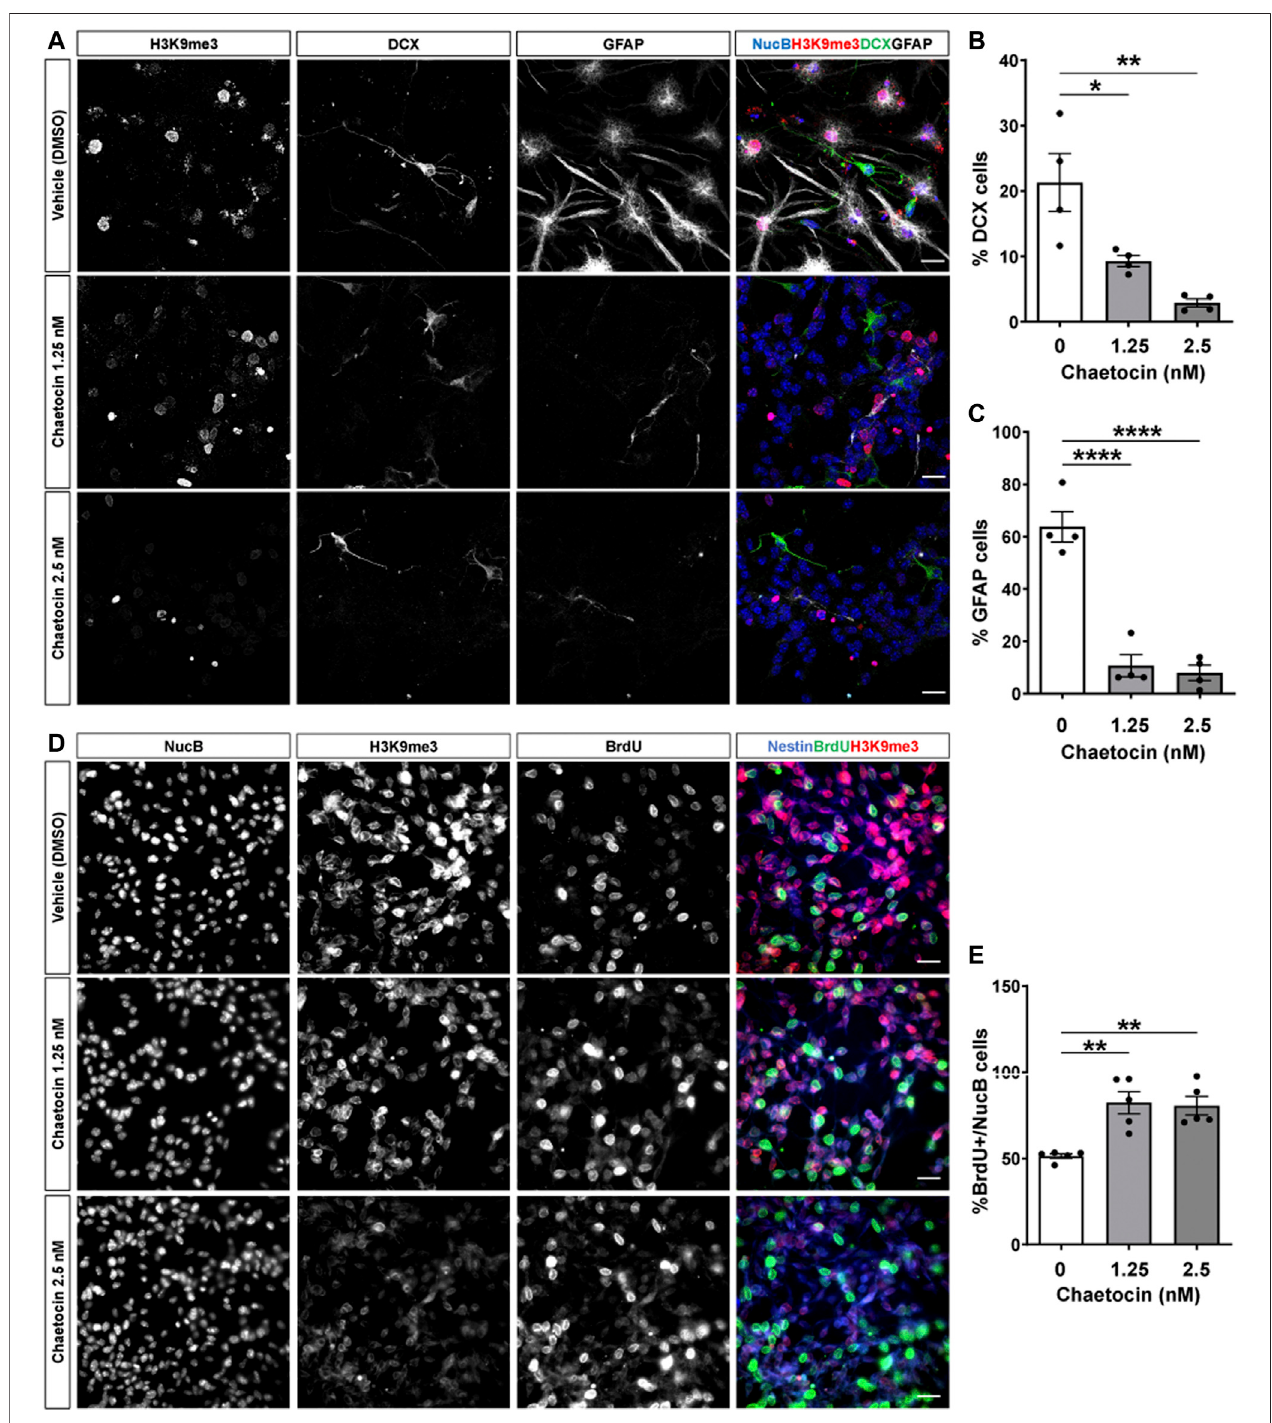
FIGURE 6 | Chaetocin induces proliferation and reduces differentiation of cultured adult hippocampal progenitors. (A) Immunostaining of H3K9me3 (red), DCX (green)andGFAP(white)andNucB(blue)inAHPdifferentiatedfor24 hinthepresenceorabsenceof1.25and2.5 nMchaetocin.Scalebar:20 μ m. (B,C) Quanti fi cation of the percentage of NucB-positive cells positive for DCX (b) or GFAP (c). (D) AHP were treated for 24 h with or without 1.25 and 2.5 nM chaetocin and were incubated with 10 μ M BrdU for the last 2 h of treatment. Images show immunostaining of H3K9me3, BrdU and the nuclear staining NucB. Merged images show H3K9me3 (red),BrdU(green)andtheprogenitorcellmarkernestin(blue).Scalebar:20 μ m. (E) Quanti fi cationofthepercentageofNucB-positivecellsthatincorporatedBrdU.Data are presented as mean ± SEM; N (cid:1) 4 (b, c) or N (cid:1) 5 (e) independent experiments. * p < 0.05, ** p < 0.01, **** p < 0.0001, one-way ANOVA followed by Bonferroni posthoc